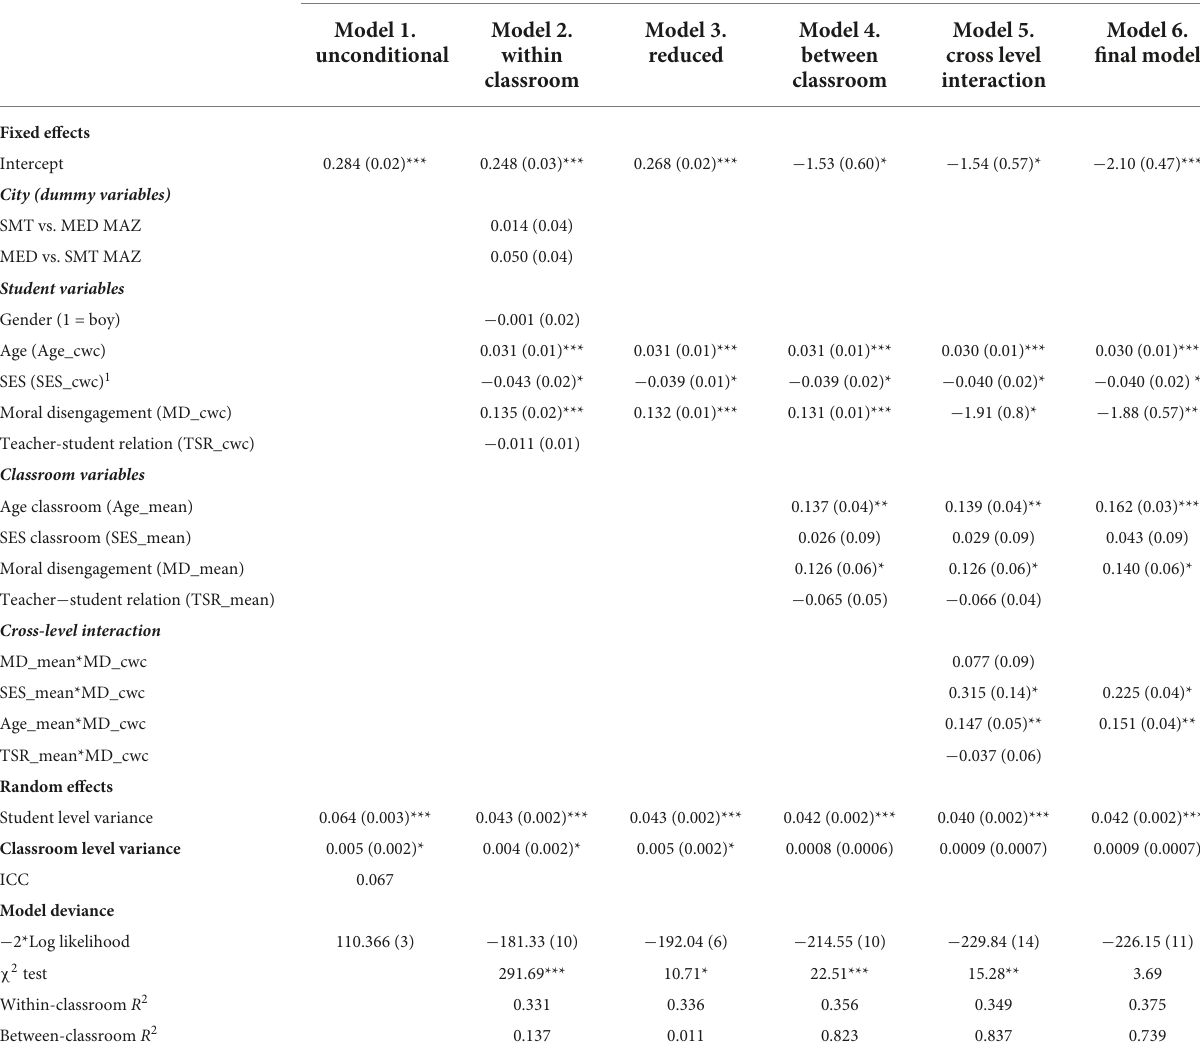
TABLE 2 Multilevel estimates for models predicting student antisocial